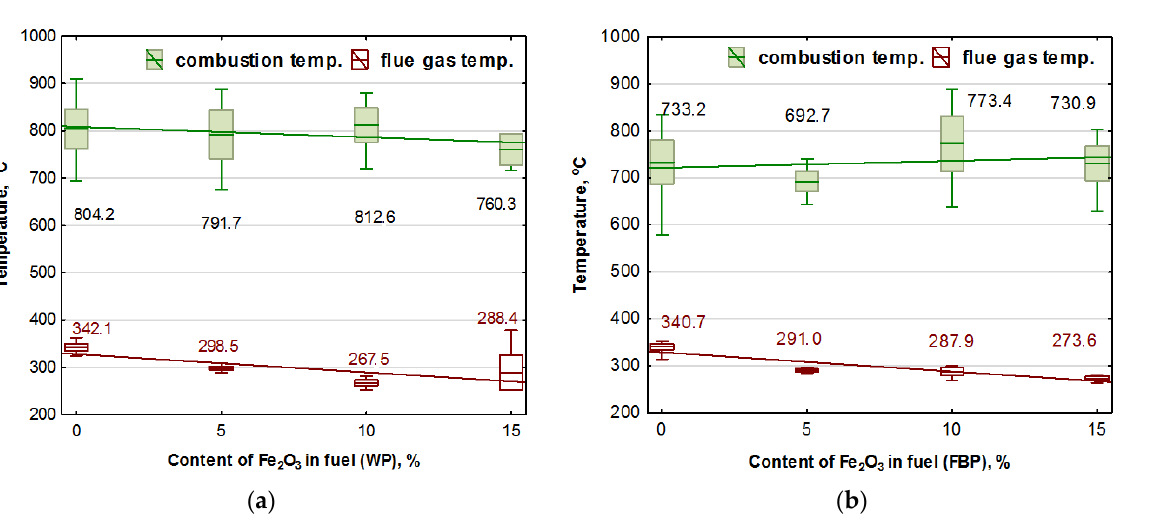
Figure 6. Influence of Fe 2 O 3 content in the fuel on the combustion temperature and boiler flue gas temperature during the combustion of wood pellets (WP) and furniture board pellets (FBP): ( a ) Wood pellets (WP); and ( b ) Furniture board pellets (FBP). The graph shows one combustion temperature for each type of pellet, calculated as the average results obtained from the three thermocouples placed above the burner. The regression equations for the trend line and the calculated values for the value of the p coefficient determined as a result of an ANOVA analysis are shown in Table 8. Table 8. Regression equations for the trend line of the dependence of pellet combustion temperature and exhaust gas temperature on the Fe 2 O 3 content of the combusted